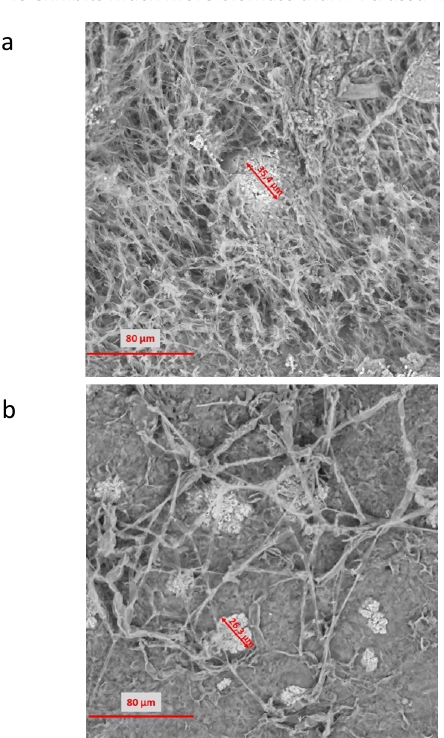
Figure 2. Scanning Electron Micrographs of CaCO 3 crystals precipitated by fungal strains grown in supplemented MMA. (a) P. chrysogenum MUM 9743 and (b) N. crassa MUM 9208.